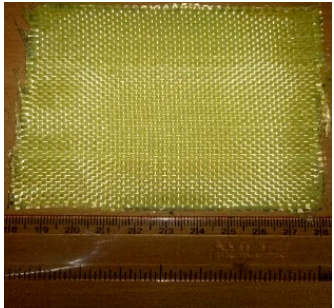
Figure 2. The Kevlar fabric.